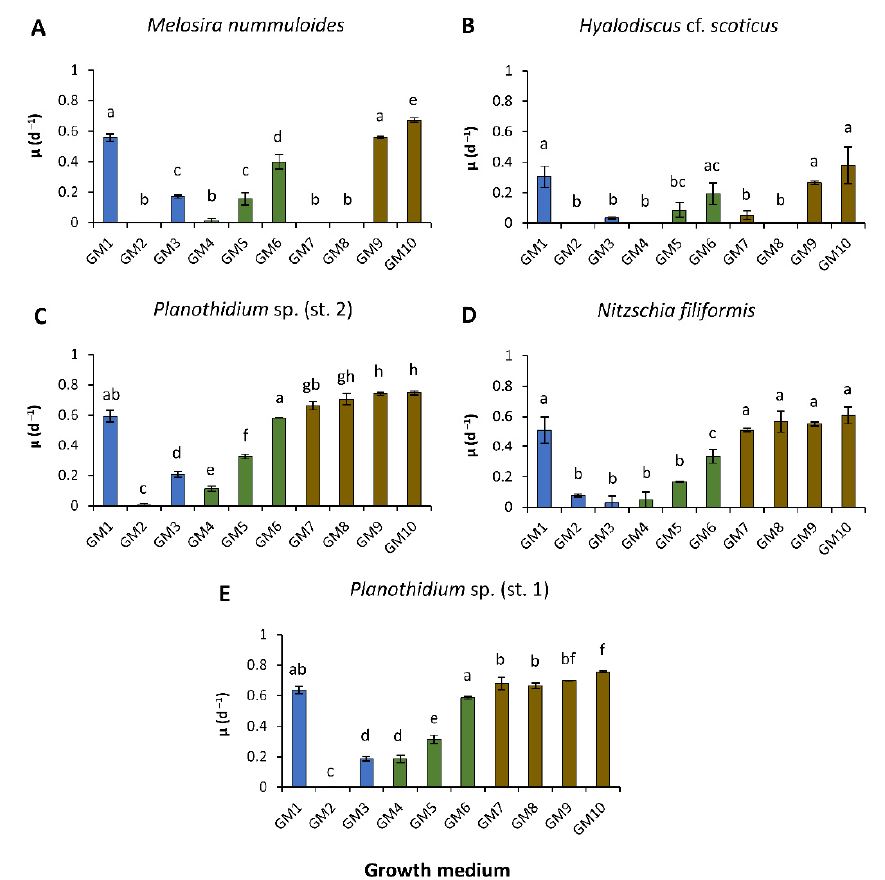
Figure 2. Specific growth rates (d − 1 ) in relation to 10 growth media (GM) (blue = Baltic Sea water base, brown = peatland water base, green = mixed water base) of two Baltic Sea ( A , B ) and three peatland benthic diatom ( C – E ) strains. Data represent mean values ± standard deviation (n = 3). Different lowercase letters represent significant levels among all means as calculated by a one-way ANOVA (Tukey’s test, p < 0.05). ( A ) Melosira nummuloides , ( B ) Hyalodiscus cf. scoticus , ( C ) Planothidium sp. (st. 2), ( D ) Nitzschia filiformis, and ( E ) Planothidium sp. (st.